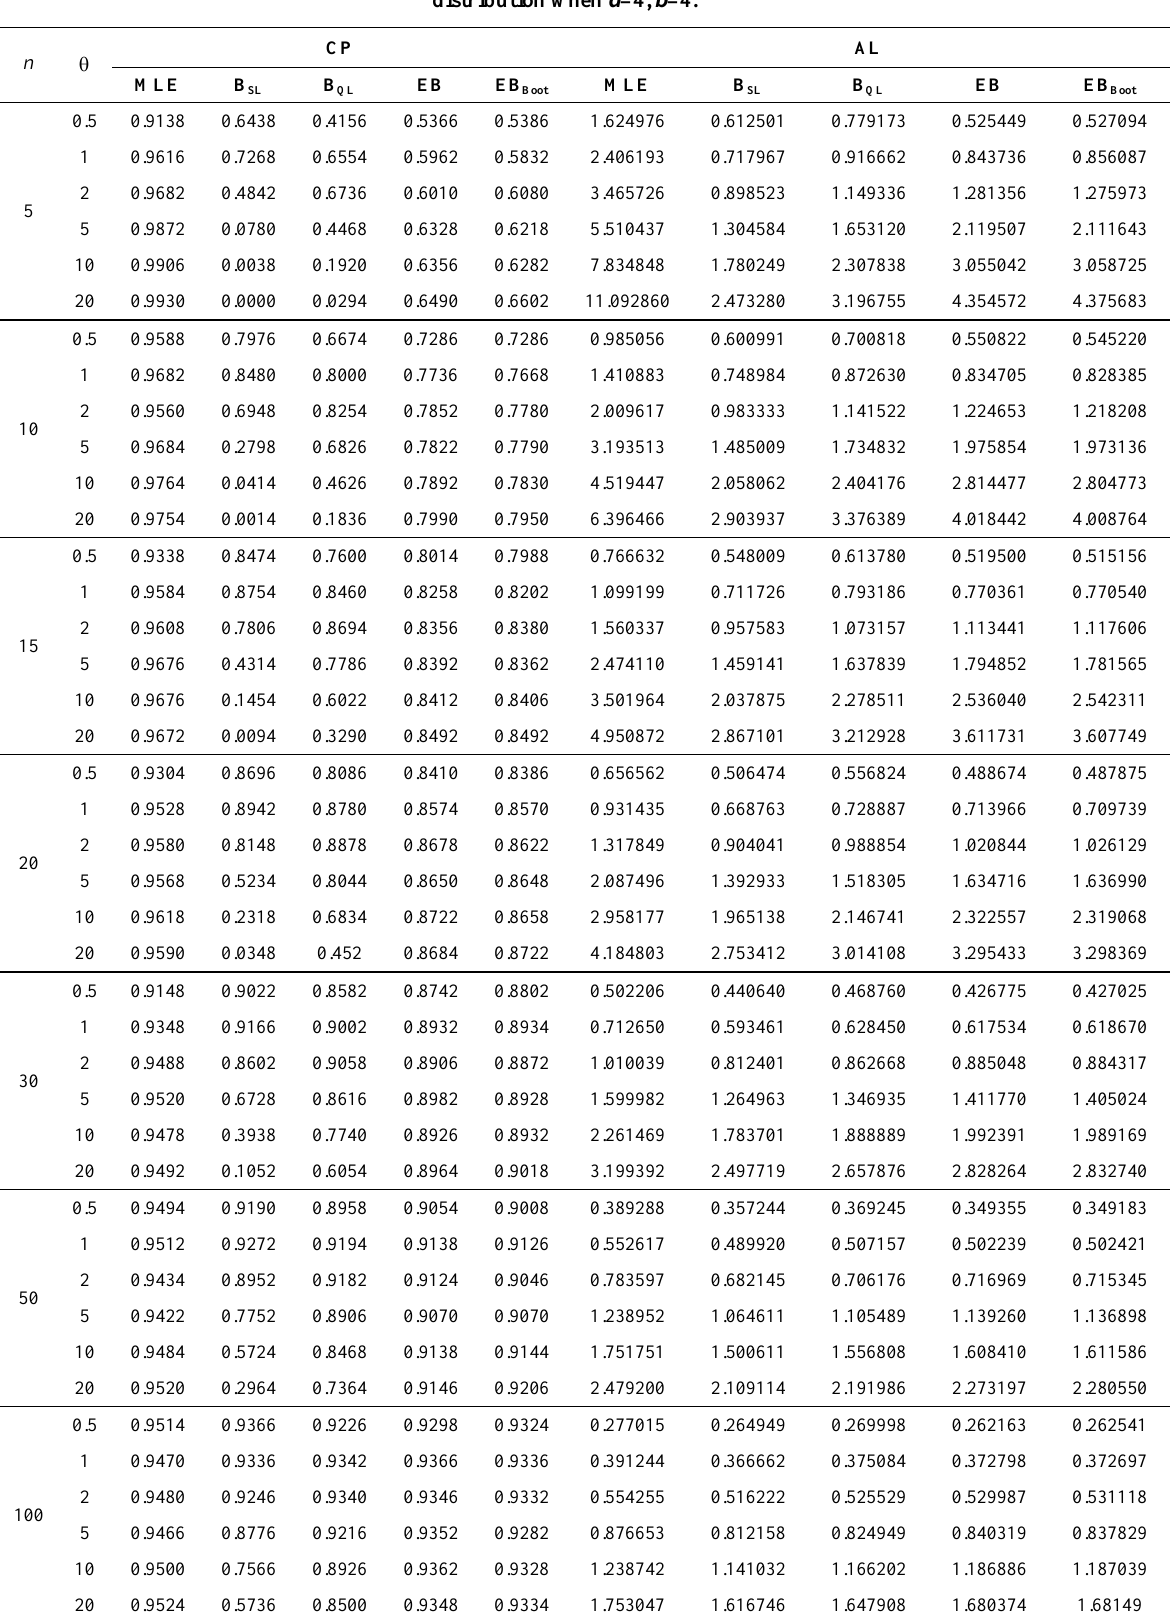
Table 8. Coverage probability (CP) and average length (AL) of 95% of confidence interval for the mean of Poisson